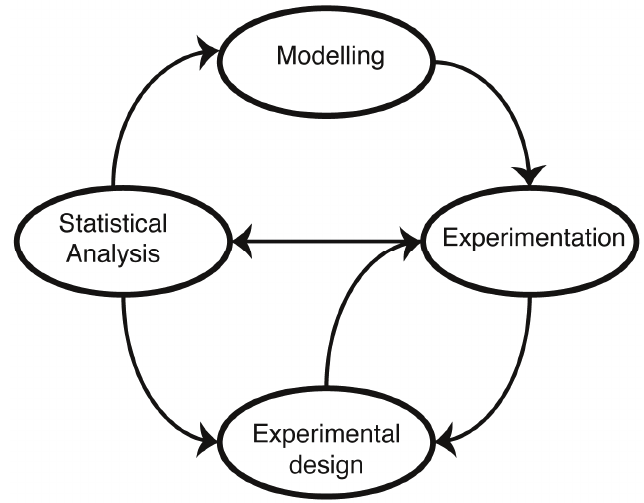
Figure 1. Mathematical modelling in molecular biology. Mathematical models of